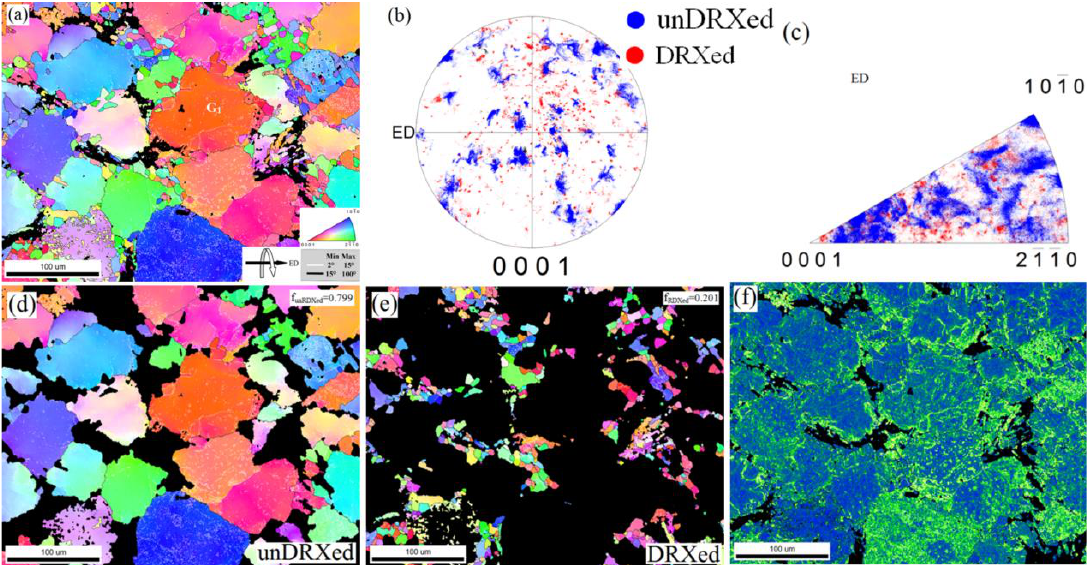
Figure 7. EBSD results of the RBEed sample in the region 5 containing DRXed grains and unDRXed grains, ( a ) IPF maps, ( b ) (0001) pole figure (PF), ( c ) inverse pole figure (IPF), separately highlighted IPF maps of ( d ) unDRXed regions and ( e ) DRXed regions, ( f ) KAM map.